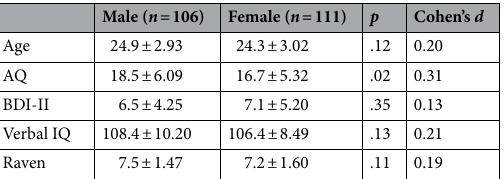
Table 1. Characteristics of our sample in the validation study (mean ± SD ). Group differences were explored using two-tailed independent samples t